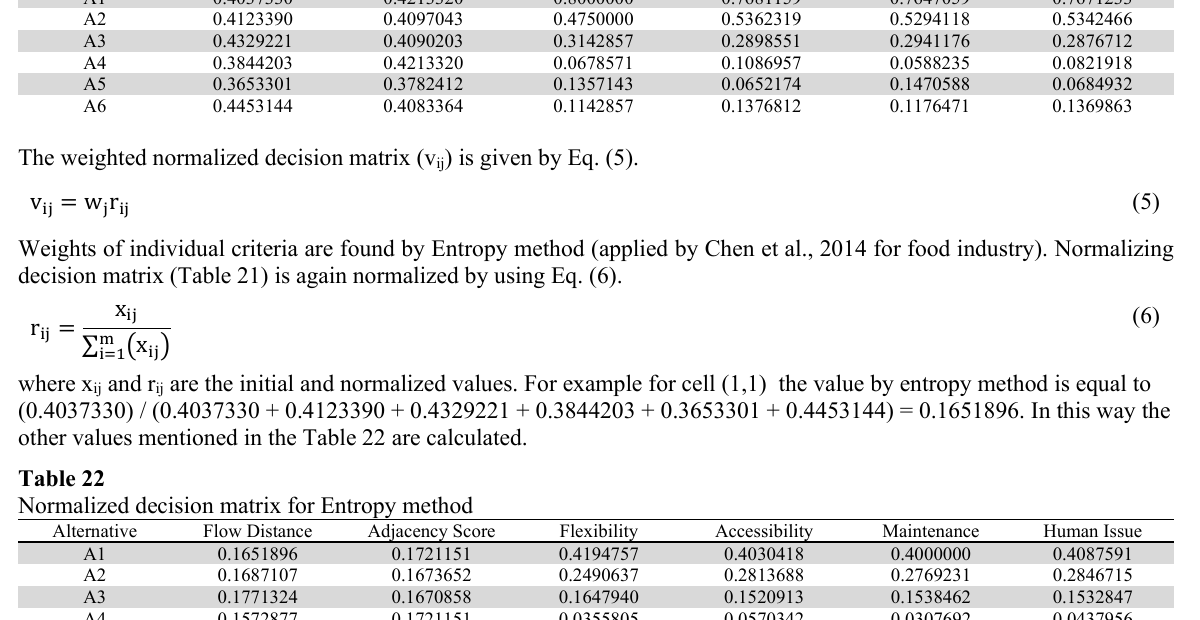
Normalized decision matrix for TOPSIS Alternative Flow Distance Adjacency Score Flexibility